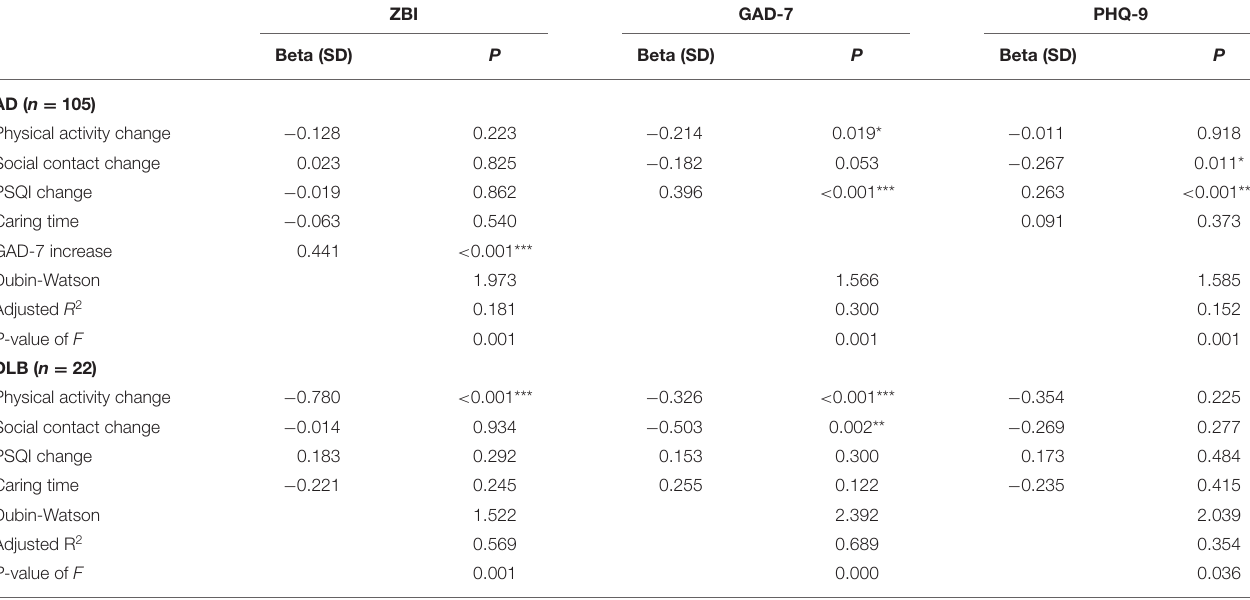
TABLE 4 | Multiple linear regression analysis of GAD-7, PHQ-9, and ZBI scores in the caregivers of AD and DLB